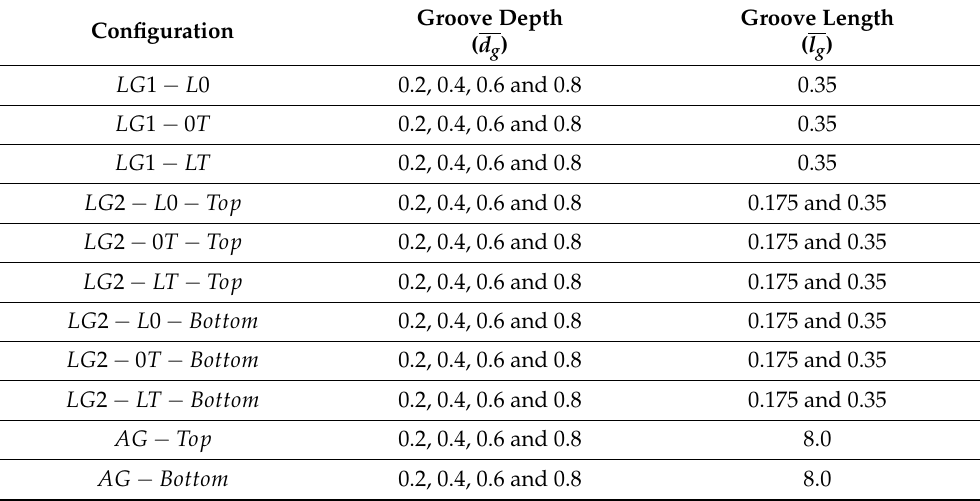
Table 1. List of groove configurations investigated in the present